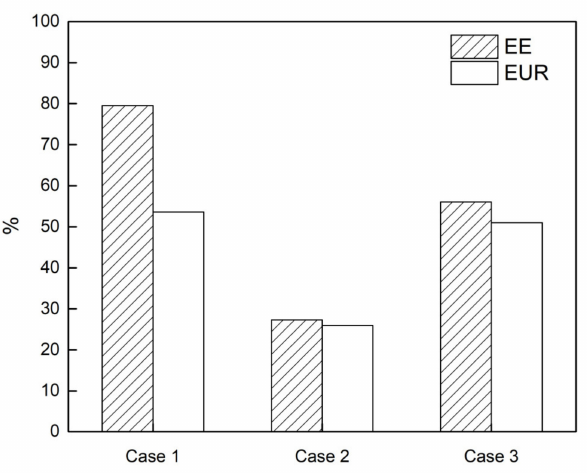
Figure 5. Comparison of flue gas waste heat exergy efficiency and exergy utilization rate in three